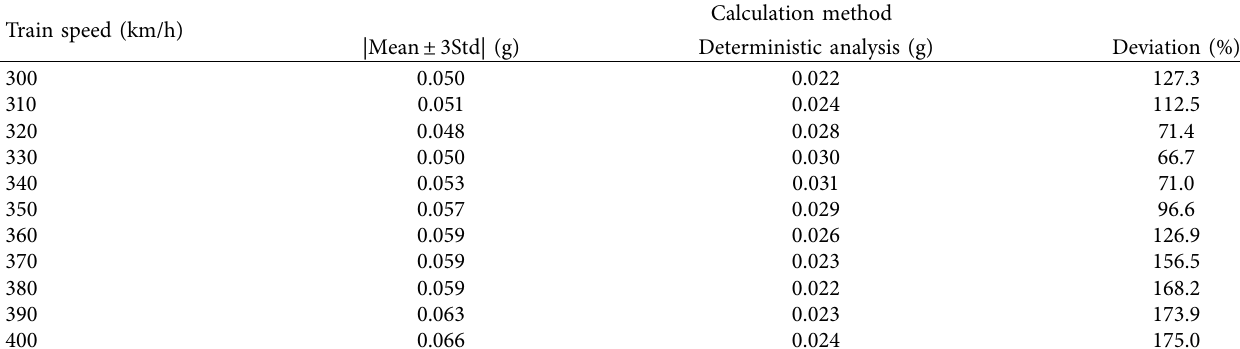
Table 5: Statistics of car body maximum acceleration with different train speeds and calculation methods.